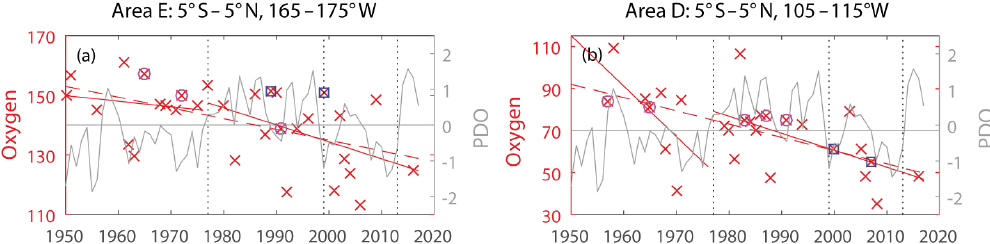
Figure 3. Annual mean oxygen concentration (µmolkg − 1 , red crosses) for years available and trends for the layer from 50 to 300m plotted for the entire time period (dashed red lines) and for the periods 1950 to 1976 for the negative PDO phase and after 1976 for the positive PDO phase (solid red lines) for (a) 5 ◦ S–5 ◦ N, 165–175 ◦ W (area E) and (b) 5 ◦ S–5 ◦ N, 105–115 ◦ W (area D). El Niño years defined as strong or very strong are marked by an additional magenta circle, strong La Niña years are marked by an additional blue square. The changes of the PDO status in 1977, 1999 and 2013 are marked by vertical dotted lines. The annual mean PDO index is shown as a grey